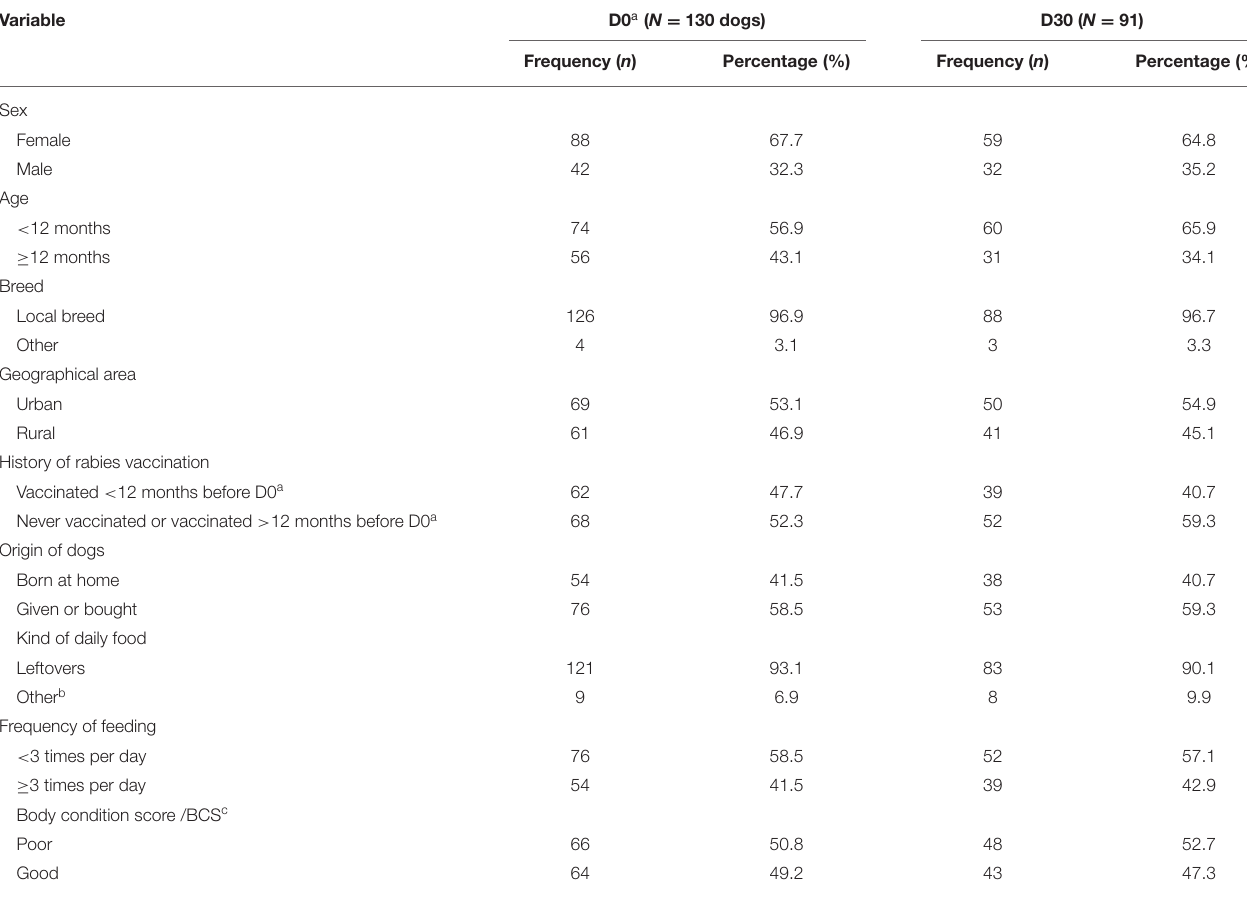
TABLE 1 | Demographic characteristics of dogs surveyed in Flores Island, Indonesia on the days of vaccination, D0 ( n = 130) and at 30 days after vaccination, D30 ( n = 91; only dogs with antibody titres < 0.5 EU/ml at D0 were considered for the analysis).